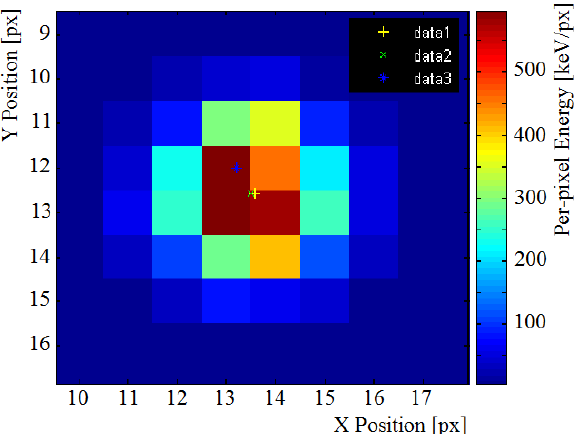
Figure 3. Centroid fitting for one event recorded. The calculated centroid coordinates are shown in the middle of this figure. Data1 shows centered calculated using the 2D Gaussian fitting, data2 shows calculated center using the estimation of 2D mean and a data3 shows the detected center using Hough transform.